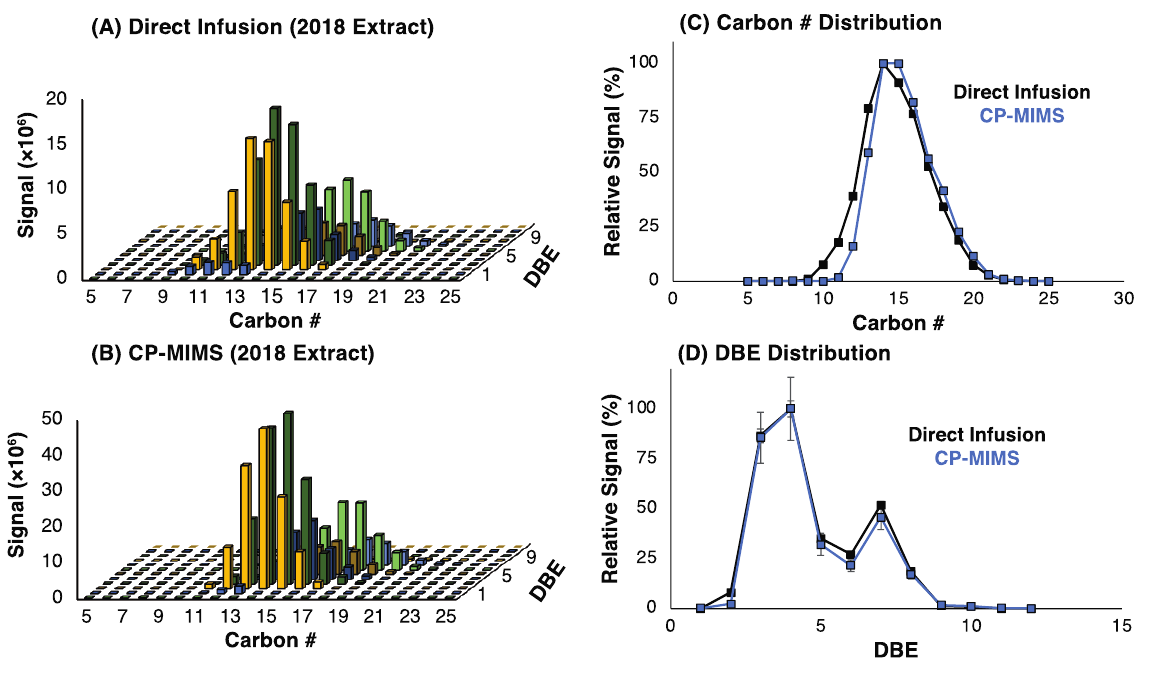
Figure 4. Relative distribution of O 2 class NAs by ( A ) direct infusion and ( B ) CP-MIMS with an Orbitrap HRMS. Panels ( C , D ) show the relative intensity by carbon # and double-bond equivalent, respectively. Points are the average of a triplicate injection, while error bars are the standard deviation across the triplicate set. The distribution of O 2 class NAs appears to be largely unperturbed by membrane transport.